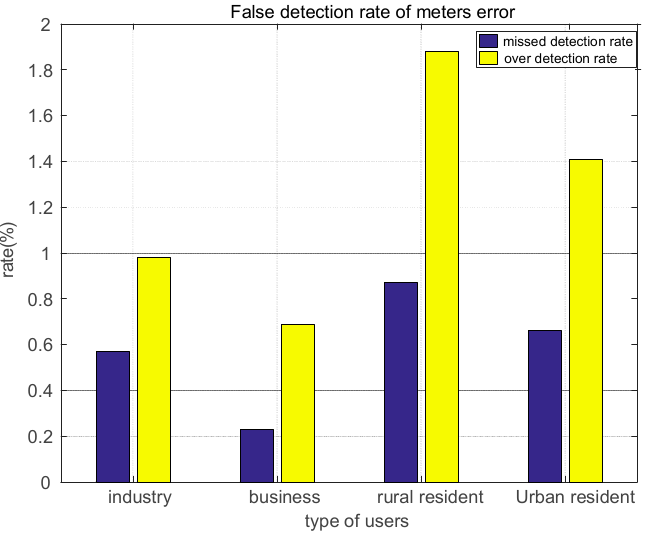
Figure 8. The false detection rate of electric meter errors.